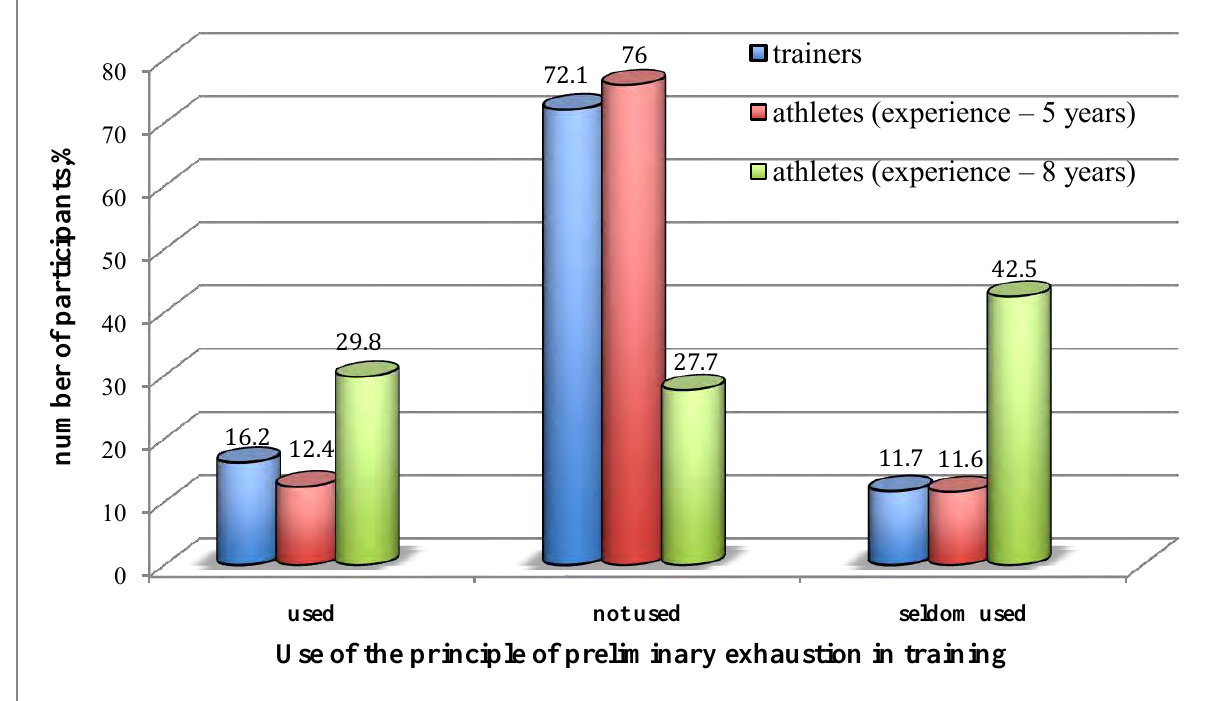
Fig. 2. Features of the principle of preliminary exhaustion use by trainers and athletes in bodybuilding at the stage of a specialized basic training (according to the survey results),